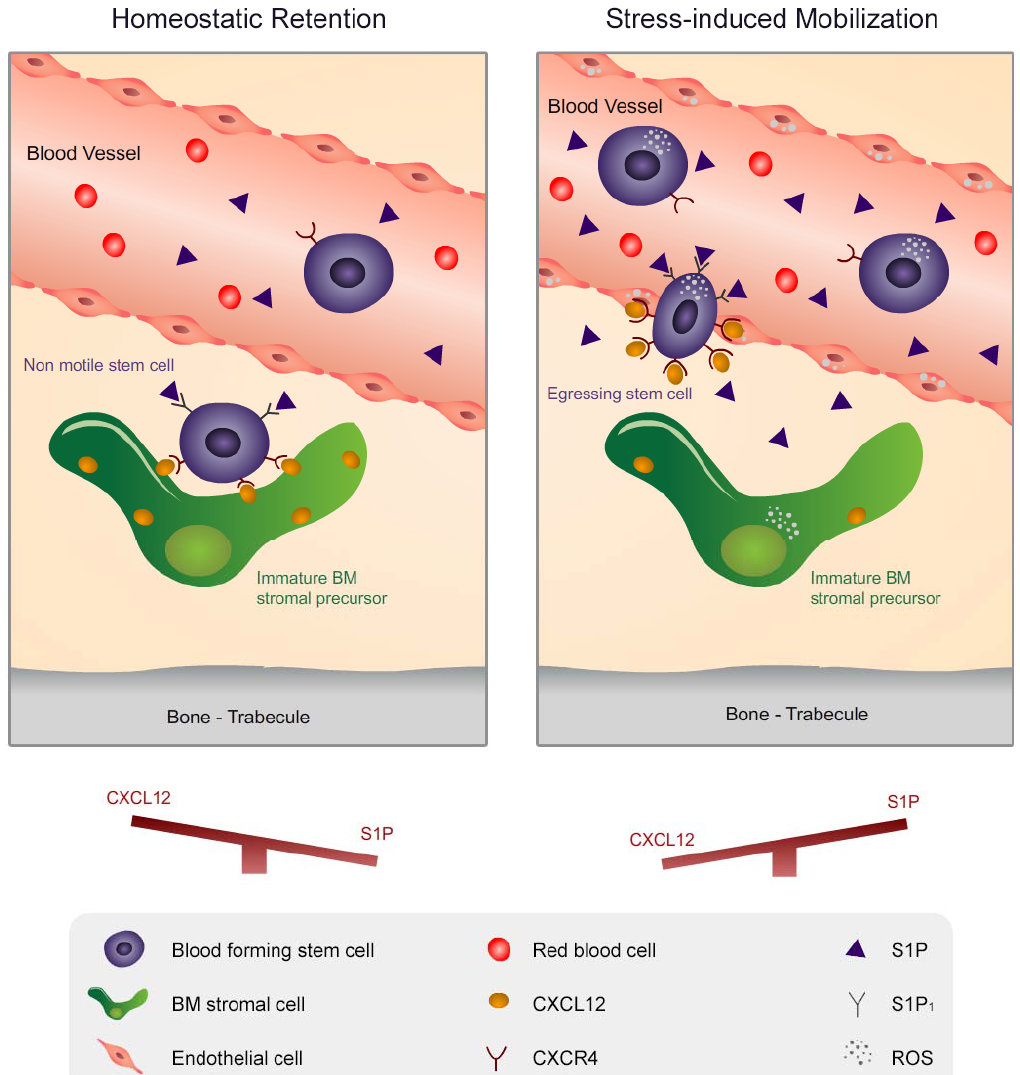
Figure 2. A schematic model for CXCL12 and S1P regulation during homeostatic retention and stress-induced mobilization. left panel: During steady state conditions, CXCL12 is highly expressed on BM stromal progenitor cells, maintaining stem cells in a non-motile quiescent state. There is a competition between plasma S1P and BM CXCL12 concentrations, determining the low stem cell egress levels. right panel: During stress- induced mobilization, CXCL12 levels are decreased in the BM, allowing detachment of stem cells from the BM stroma and switching to a motile proliferative/differentiating state. Concomitantly, S1P levels are increased in the BM and plasma, thus facilitating ROS signaling in stem cells to increase their active motile state as well as in BM stromal progenitor cells to further facilitate CXCL12